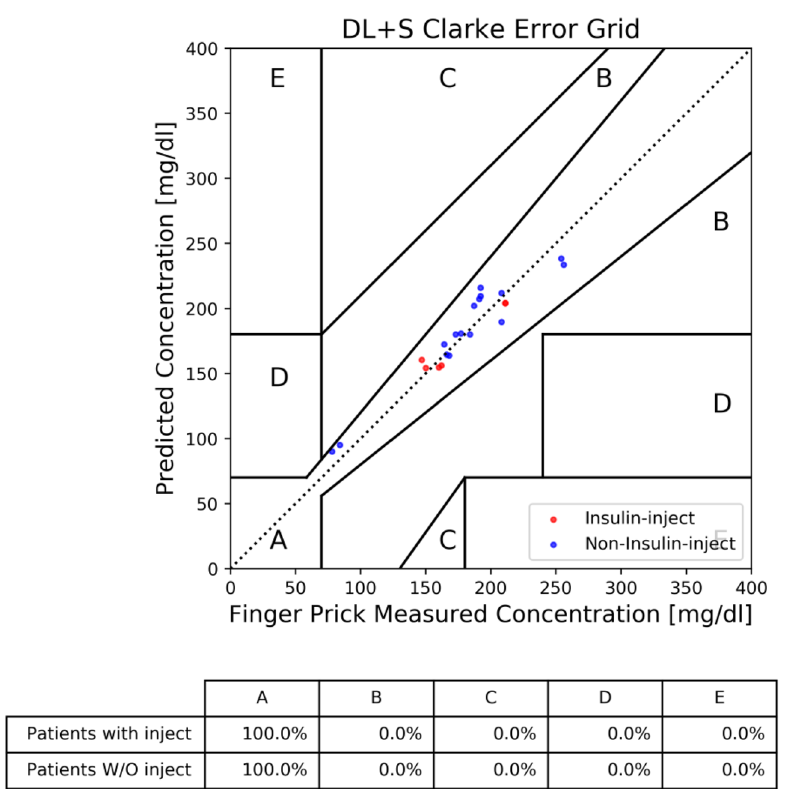
Figure 4. Comparison of DL + S predictions for patients with and without insulin treatment at rounds